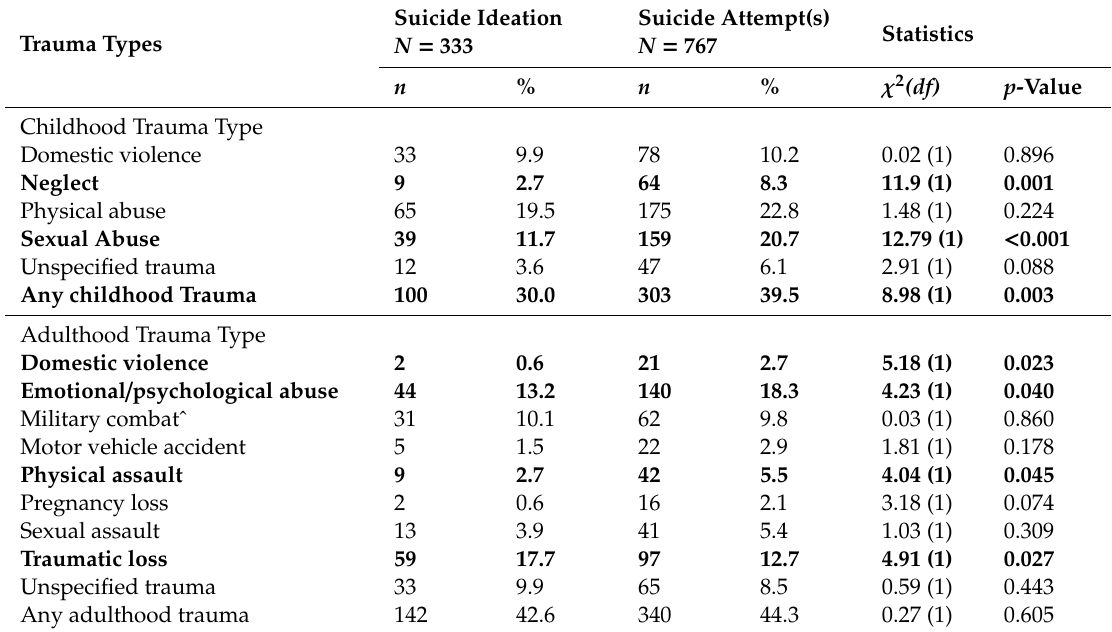
Table 2. Comparison of documented lifetime trauma exposure characteristics between patients hospitalized for suicide ideation only or following a suicide attempt ( N =